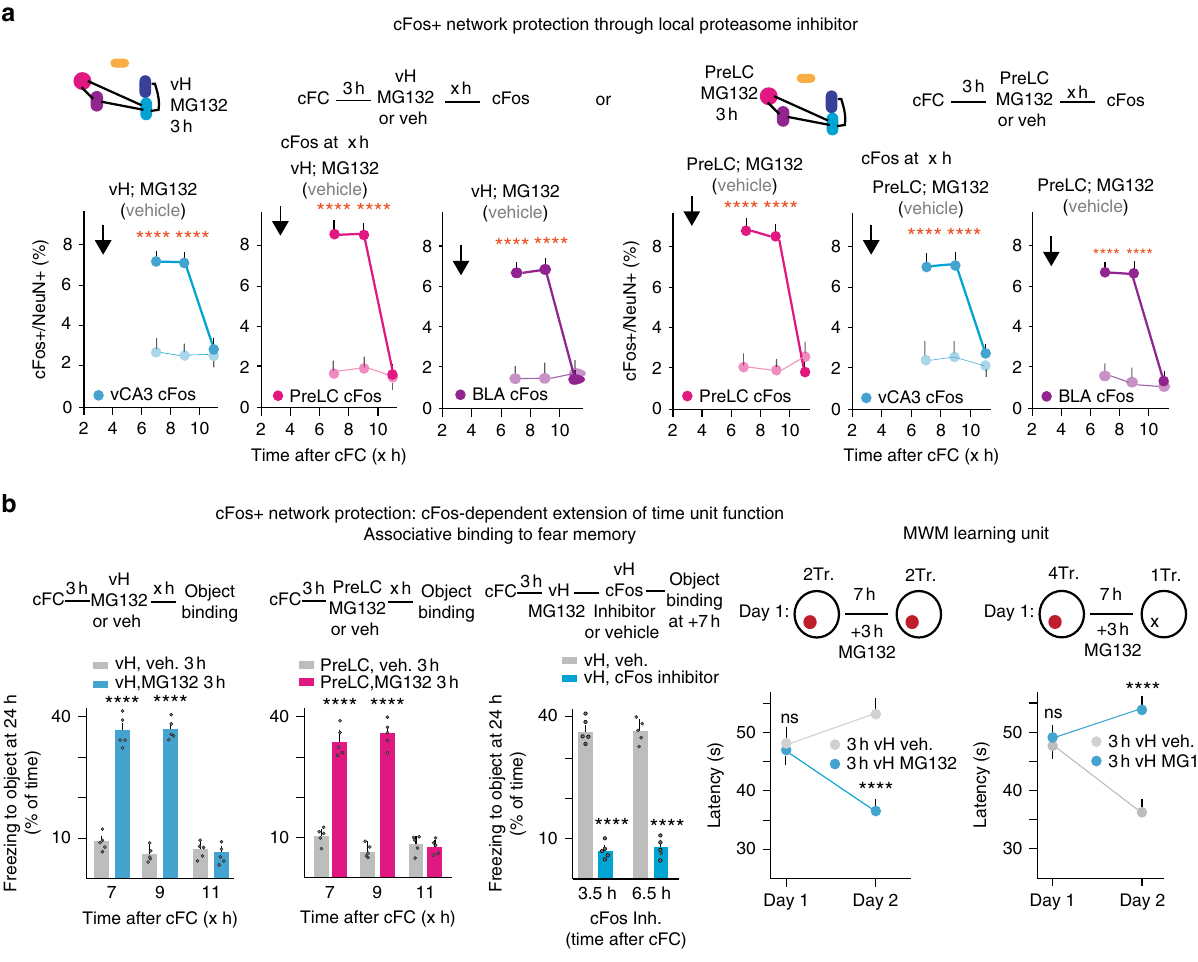
Fig. 4 cFos-dependent extension of time unit for learning upon local inhibition of protein degradation. Preventing protein degradation locally with proteasome inhibitor is suf fi cient to extend time window of cFos expression throughout the cFos network. Local delivery of MG132 at 3 h to vH (left); pale colors: vehicle controls. vCA3: Two-way ANOVA, Interaction P < 0.0001, PreLC: Two-way ANOVA, Interaction, P < 0.0001, BLA: Two-way ANOVA, Interaction, P < 0.0001; n = 9, 9, 5, 6, 5, 6. Local delivery of MG132 at 3 h to PreLC (right); PreLC: Two-way ANOVA, Interaction, P < 0.0001, vCA3: Two- way ANOVA, Interaction, P < 0.0001, BLA: Two-way ANOVA, Interaction, P < 0.0001, n = 5, 5, 5, 5, 5, 5. b cFos-dependent extension of time unit function. Left: extension of fear memory binding time unit by local delivery of proteasome inhibitor. vH treatment: Two-way ANOVA, Interaction, P < 0.0001, n = 5 each; PreL treatment: Two-way ANOVA, Interaction, P < 0.0001, n = 5 each. Center: cFos dependence of time unit extension: Two-way ANOVA, Treatment, P < 0.0001, n = 5 each. Right: extension of time unit for trial completion [Two-way RM ANOVA, Interaction, P = 0.0023, n = 5 in each group. Extension of time unit for interference [Two-way RM ANOVA, Interaction, P = 0.0003, n = 5 in each group. Error bars: SEM; P < 0.05 (*), 0.01 (**), 0.001 (***), 0.0001 (****). For a more detailed description of the statistical analysis please refer to Supplementary Table